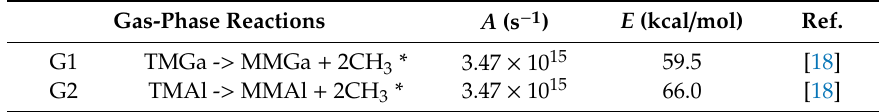
Table 2. Gas-phase (G) reaction pathways and kinetic parameters for AlGaAs growth.